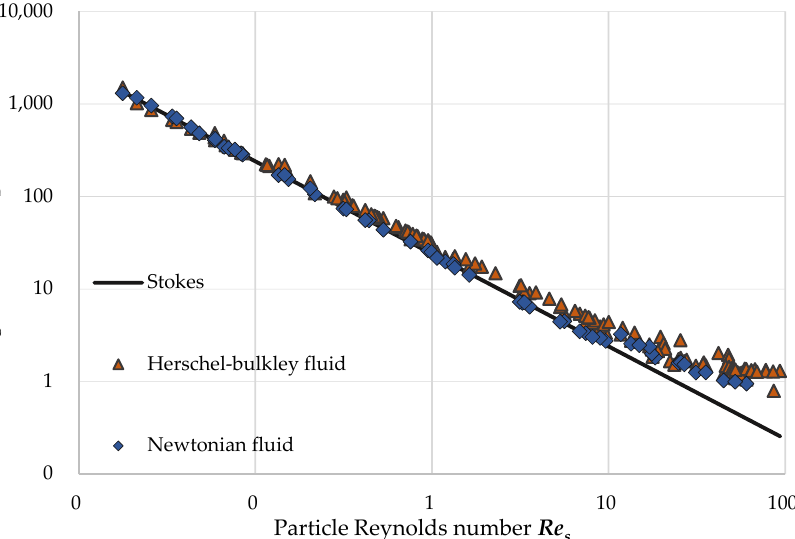
Figure 7. Variation in C D - Re s relationship of 165 groups of spherical particles obtained from sedimentation experiment.